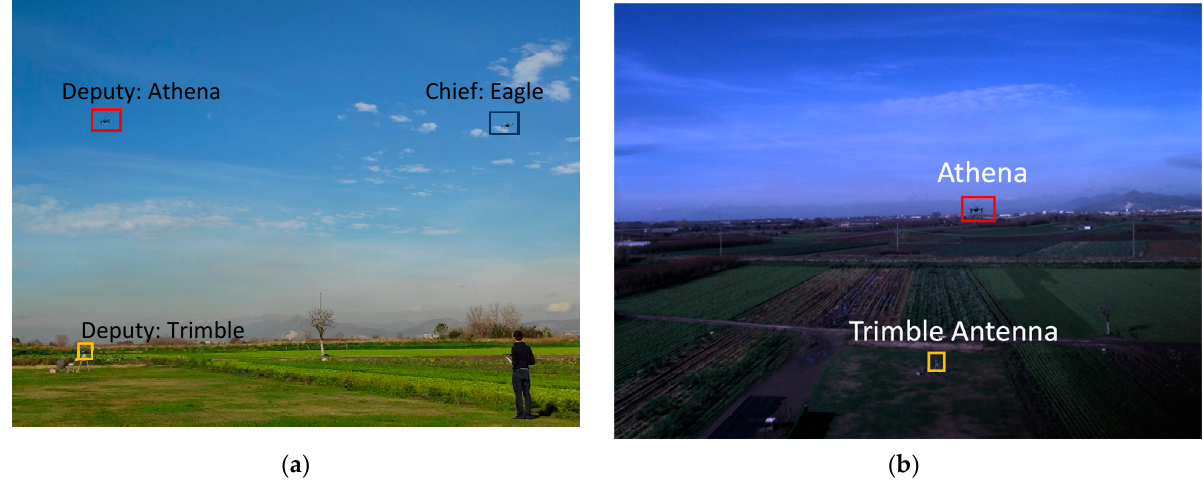
Figure 21. ( a ) Flight image, ( b ) Image acquired by chief vehicle (Eagle) during the flight.